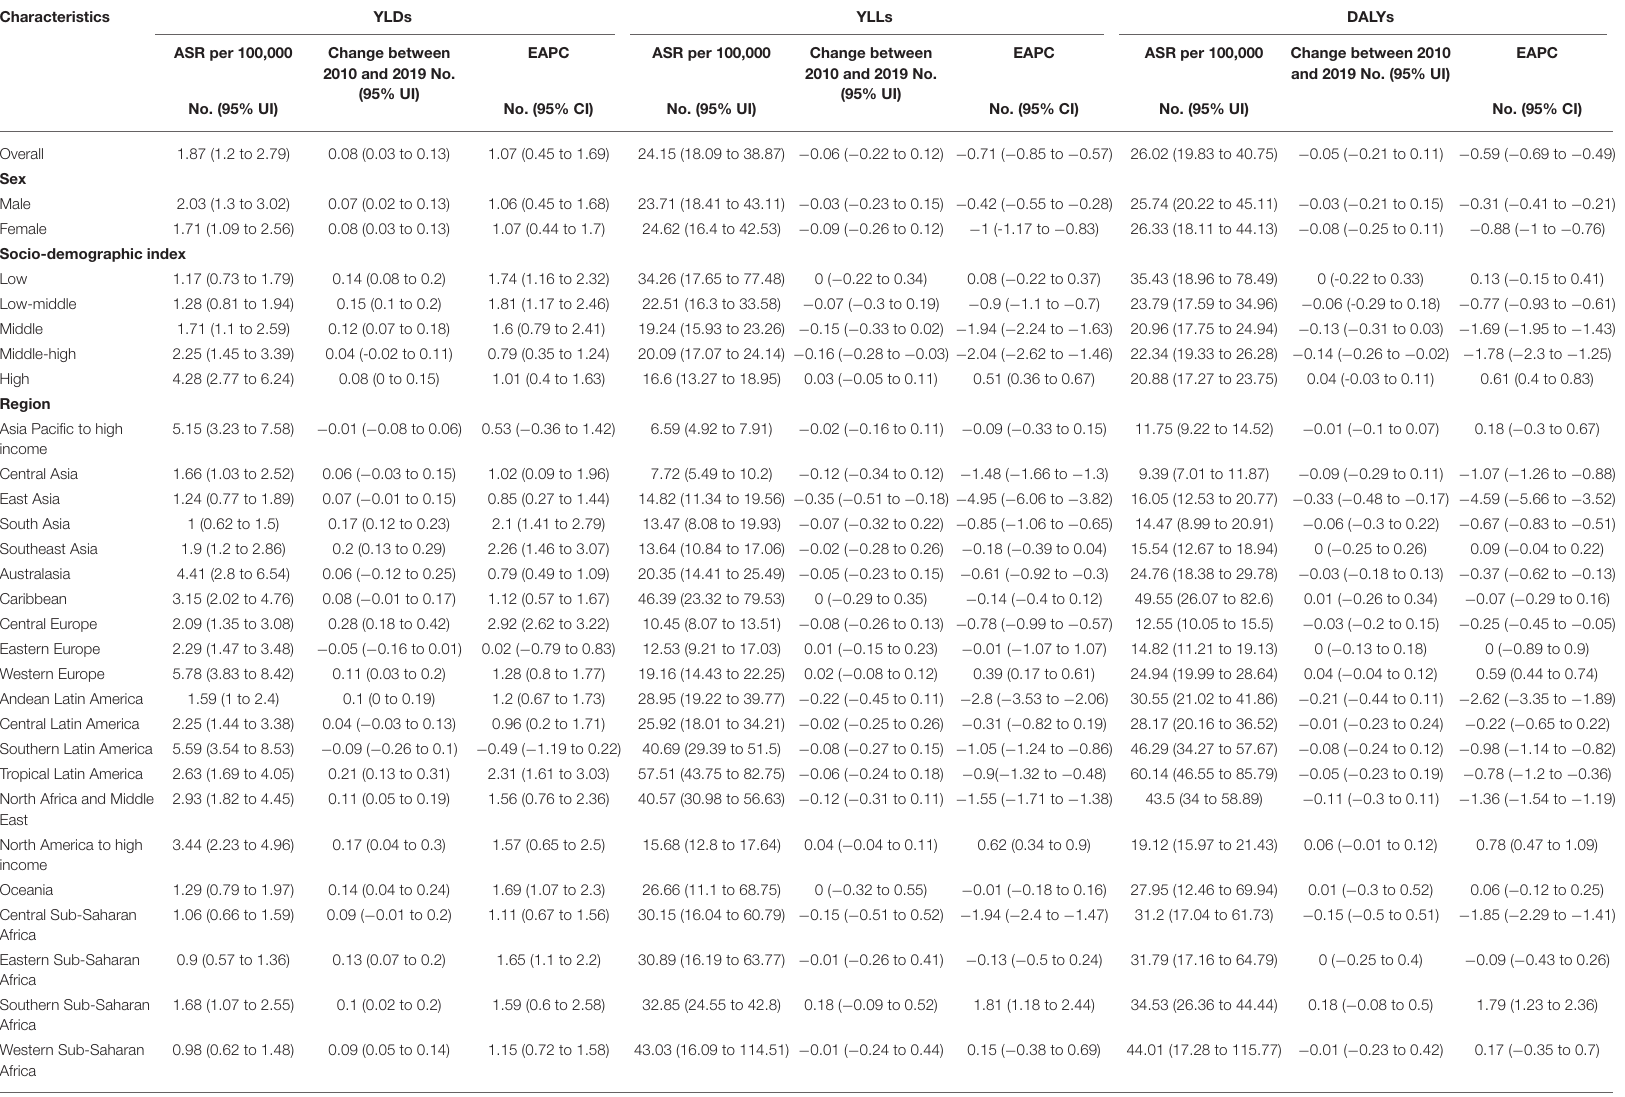
TABLE 1 | The age-standardized rates for YLDs, YLLs, and DALYs of Down syndrome in 2019 and their temporal trends from 2010 to 2019.